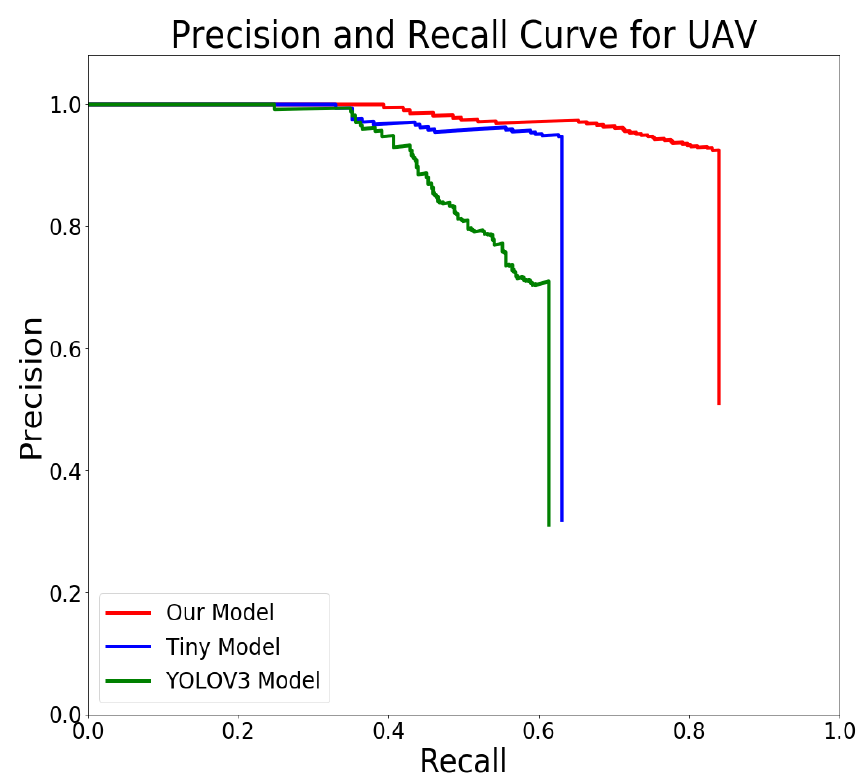
Figure 4. Precision and recall scores of FastUAV-NET and the state-of-the-art detection methods on the UAV testing